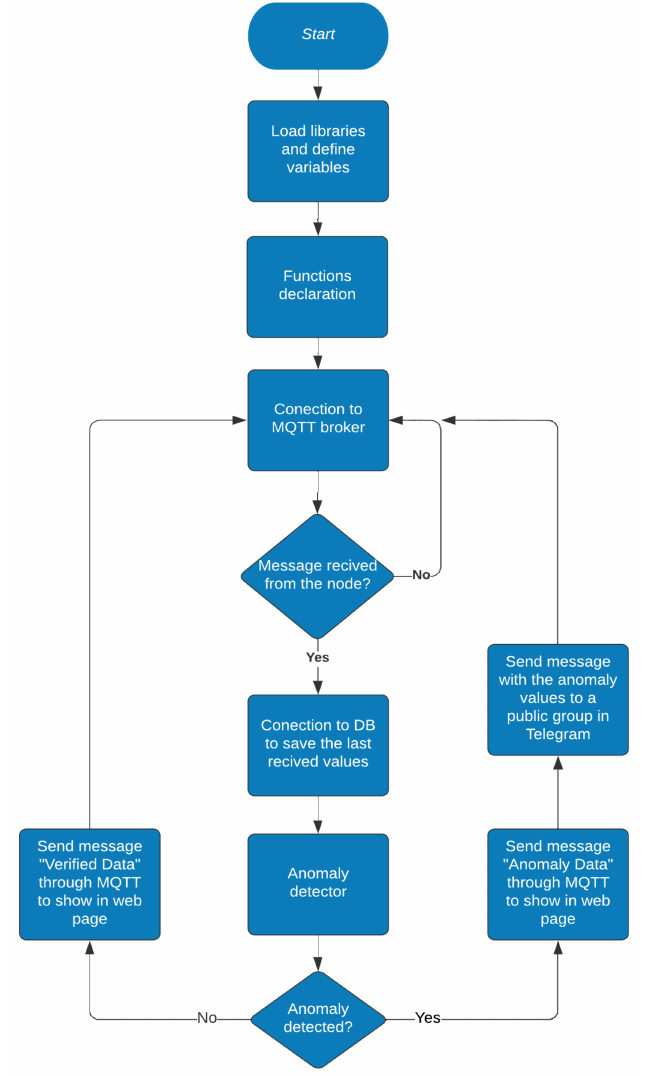
Figure 4. Flowchart of the process of anomaly detection module of unsupervised learning integrated with